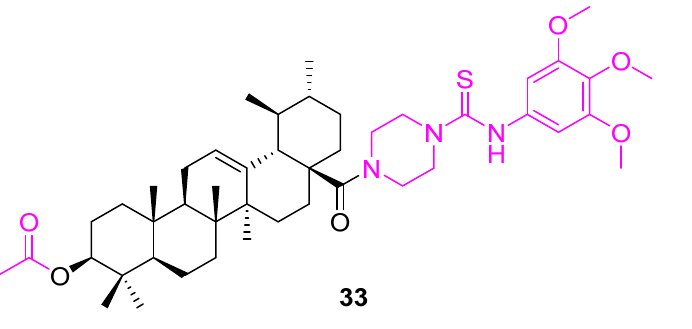
Figure 21. Structure of 33 .